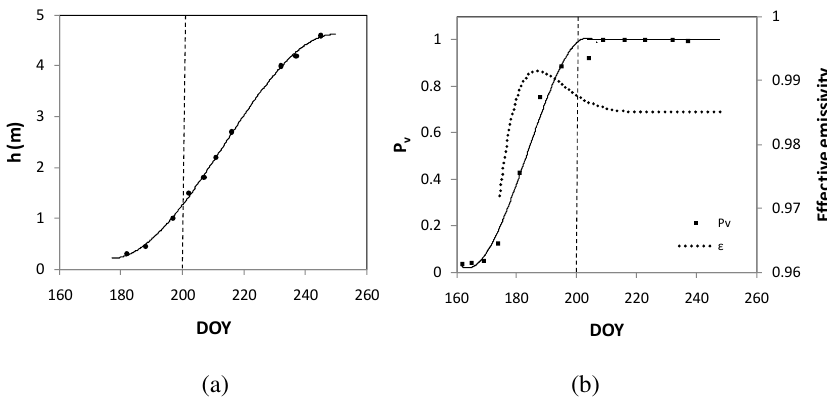
Figure 2. (a) Evolution of the modelled sorghum height during the experiment (line) superposed to the field measurements (dots). (b) Evolution of the modelled P v during the experiment (line) superposed to the field measurements (dots), together with the modelled effective emissivity.